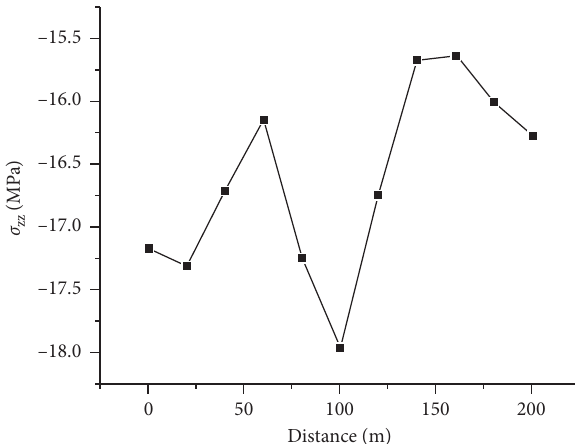
Figure 8: The vertical stress of monitoring points in the third left working